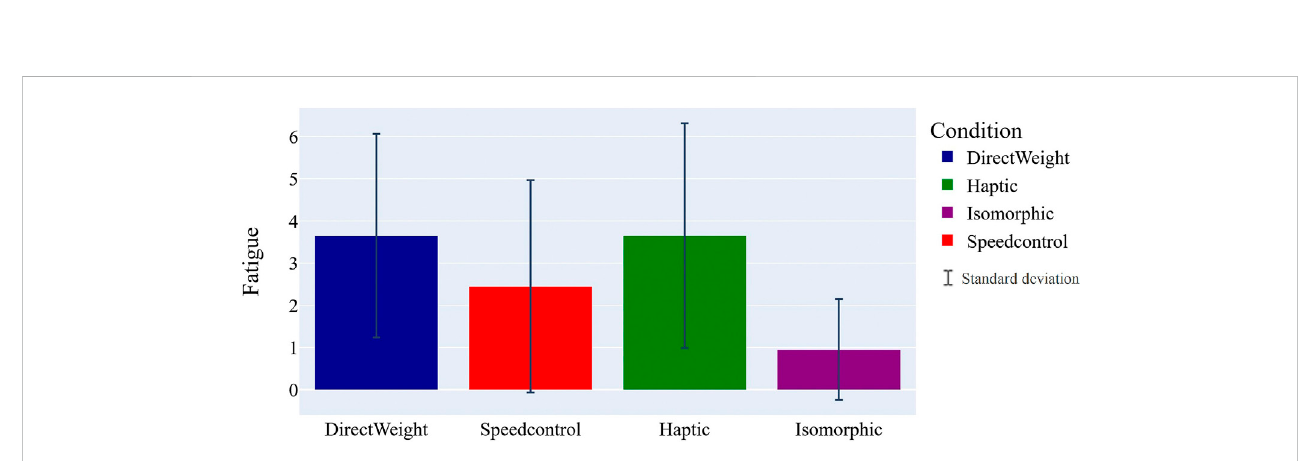
Frontiers in Virtual